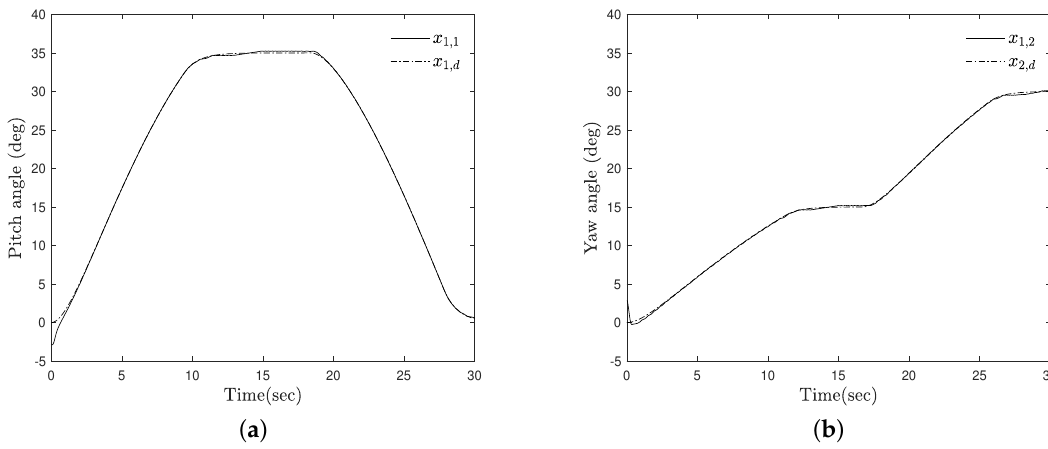
Figure 3. Tracking results for simulation ( a ) x 1,1 and x 1, d ( b ) x 1,2 and x 2, d